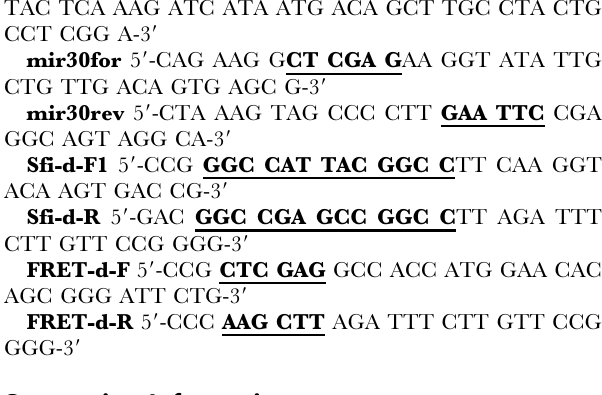
Figure S1 The split ubiquitin membrane yeast two Figure S2 CD81 interacts with CD3 d in the presence and absence of surface TCR expression. ( a ) De novo TCR